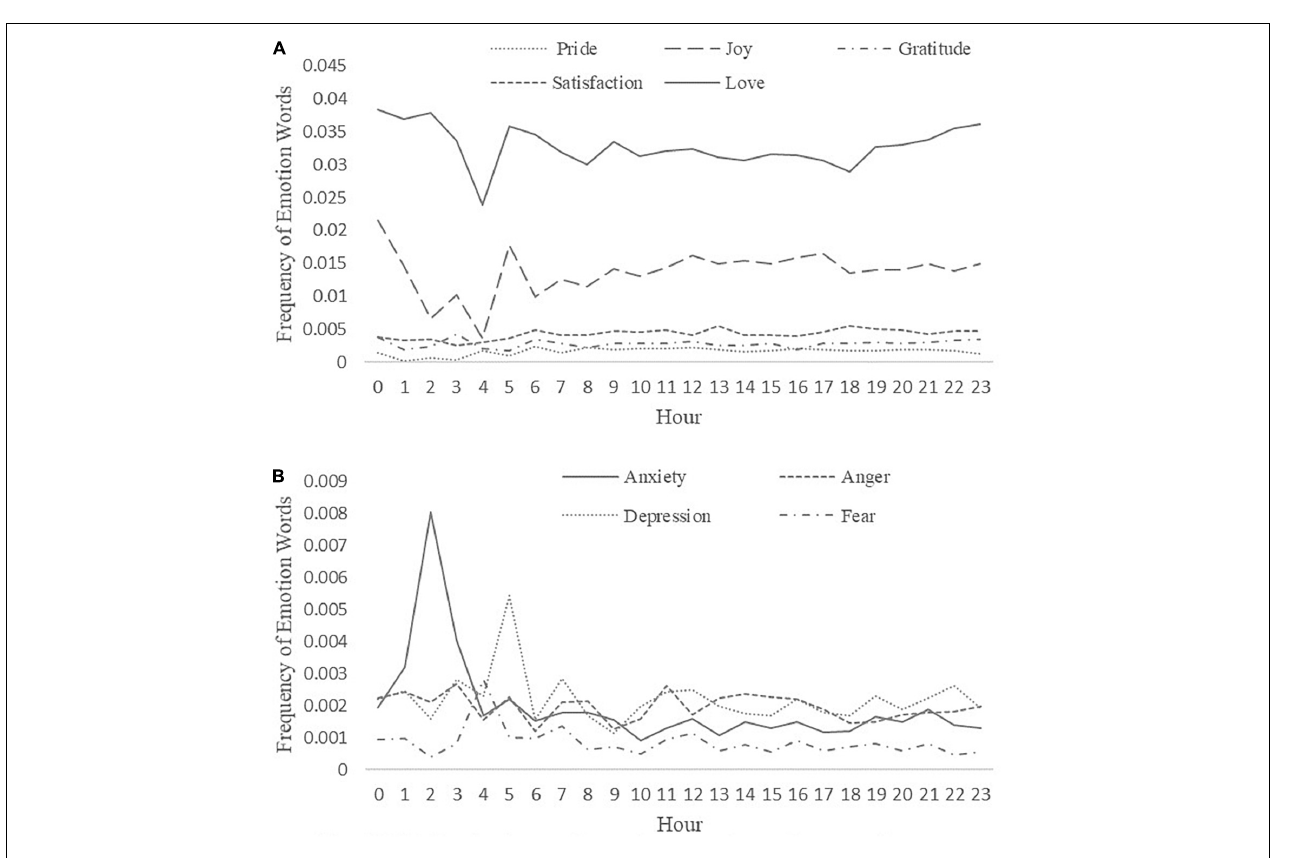
FIGURE 2 | The daily rhythm changes of positive emotions and negative emotions.